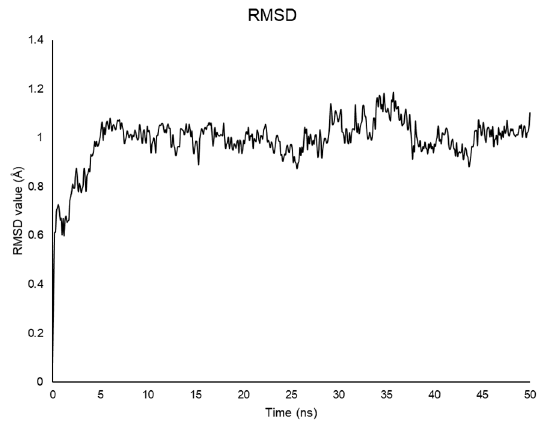
Figure 5. RMSD plot values for the backbone atoms of A β (1–42) throughout the 50 ns simulation as a function of time.